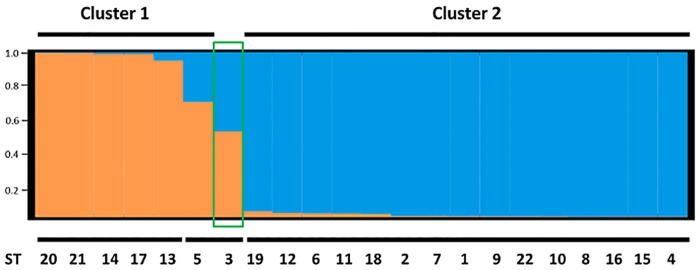
Bayesian clustering of B. goodwinii STs inferred using the programme STRUCTURE.Vertical columns represent individual STs, labelled below the figure, whose membership probabilities to the two clusters are represented by orange and blue sections of the column.